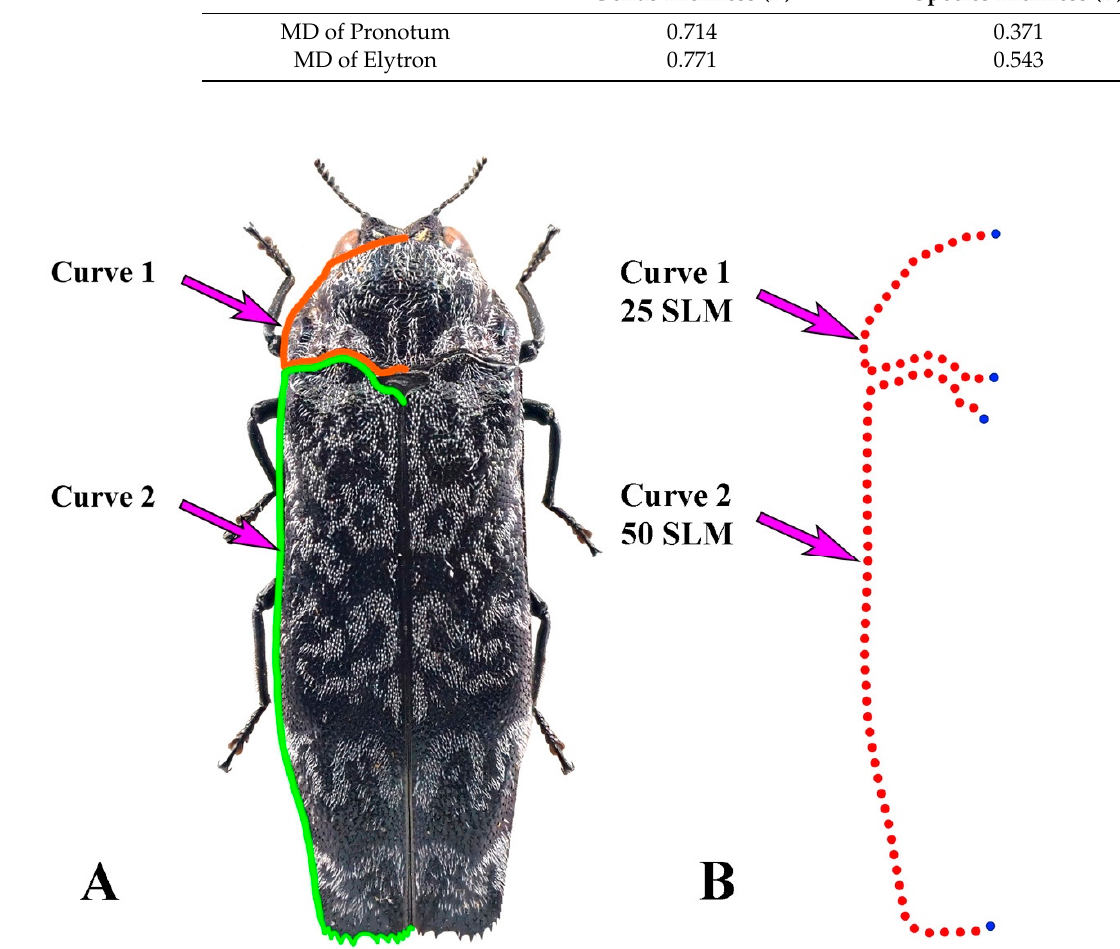
Figure 2. Description of the curves used in the geometric morphometric analysis. The positions selected for the pronotum and elytron curves are represented by Coraebus spathatus in dorsal view. ( A ) Curve 1 and Curve 2 are shown in orange and green outlines for the counters of pronotum and elytron, respectively. ( B ) Curve 1 was resampled in 25 semi-landmarks; Curve 2 was resampled in 50 semi-landmarks. The semi-landmarks are shown in red points and the terminal ones are shown in blue.